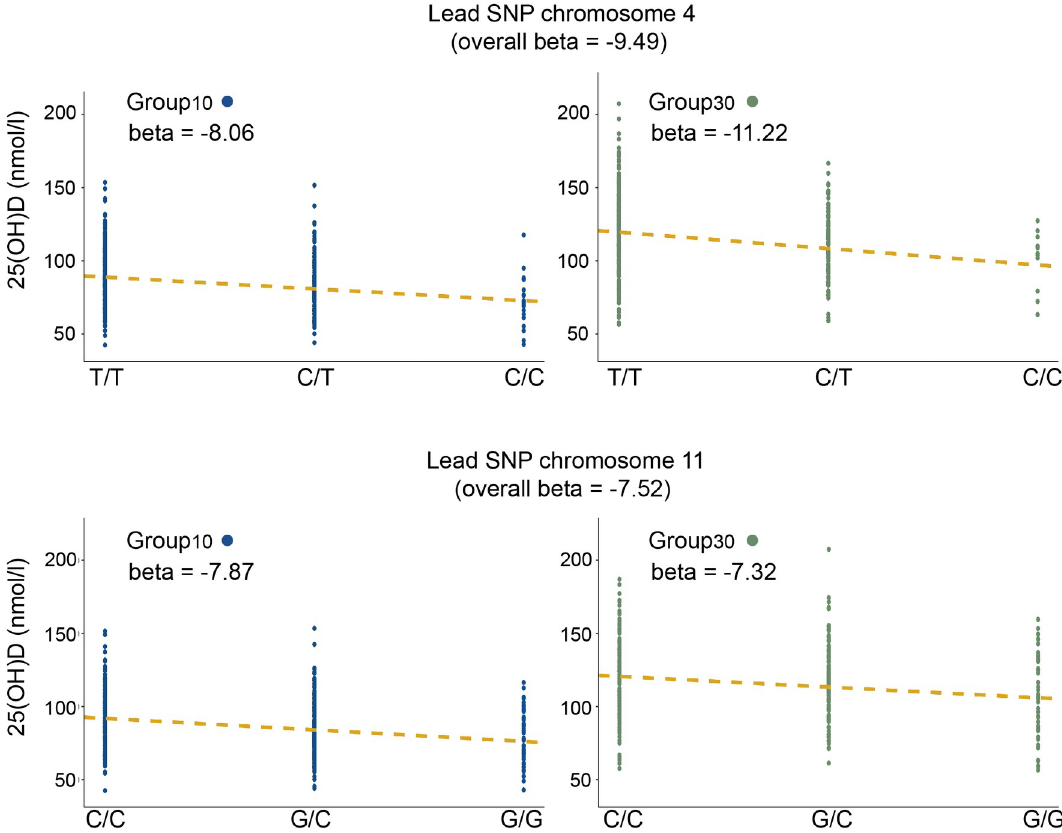
Fig 3. Association statistics for Group 10 vs Group 30 . The analysis focuses on the lead SNPs at each significantly associated locus while separating the randomization groups. The results show that the lead SNP on chromosome 4 (rs1155563) seem to have a larger effect in the group receiving 30 μ g of daily vitamin D (Group 30 ) than in the group receiving 10 μ g (Group 10 ). The lead SNP on chromosome 11 (rs10832310) instead displayed a similar effect size regardless of randomization group, suggesting that the locus on chromosome 4 can modulate supplementation response, while the locus on chromosome 11 does not. Y-axis is 25(OH)D at 24